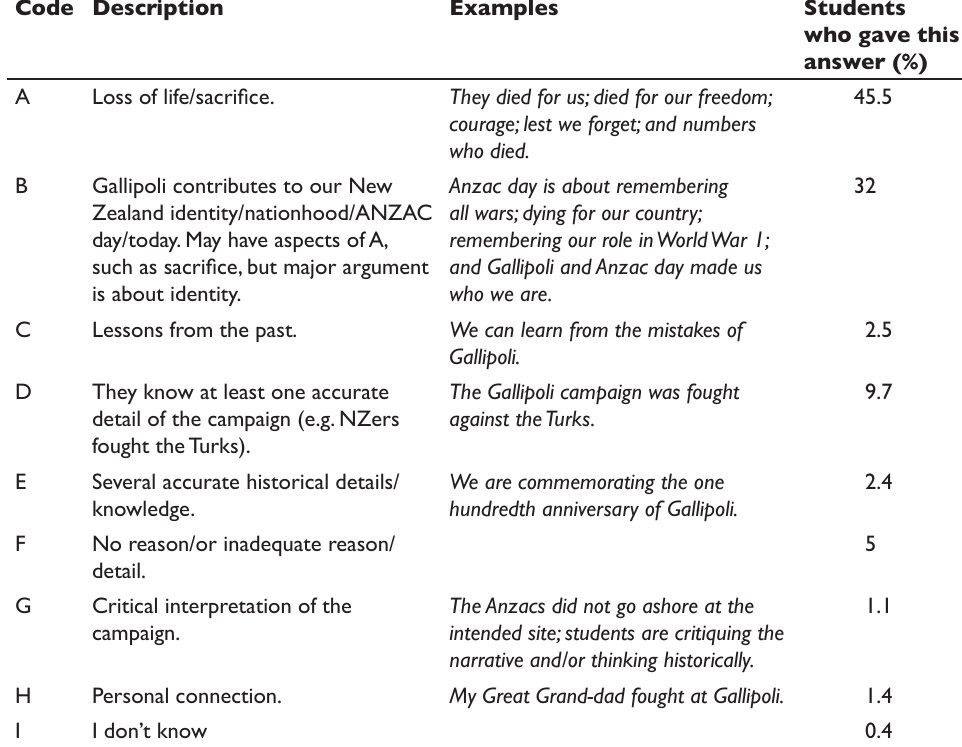
Table 1: Codesusedtoanalysequestiontwointhesurvey Code